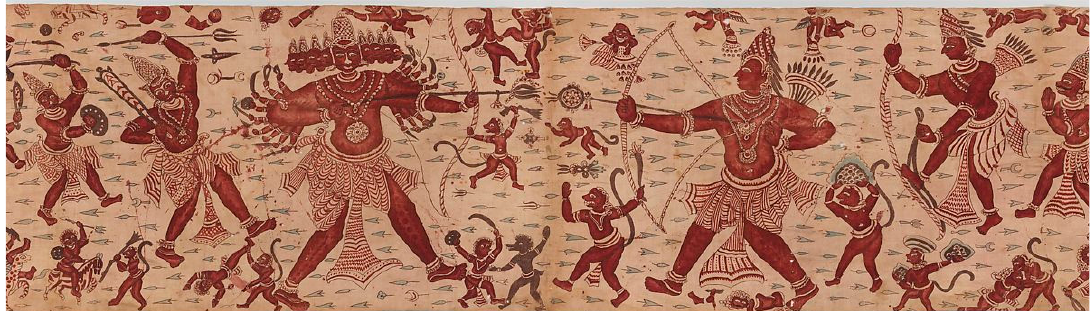
Figure 2. Folio from the Freer Ramayana , 1597–1605, Mughal, India, ink, opaque water color and gold on paper. Freer Gallery of Art, Smithsonian Institution, Washington, D.C.: Gift of Charles Lang Freer, F1907.271.173-346.